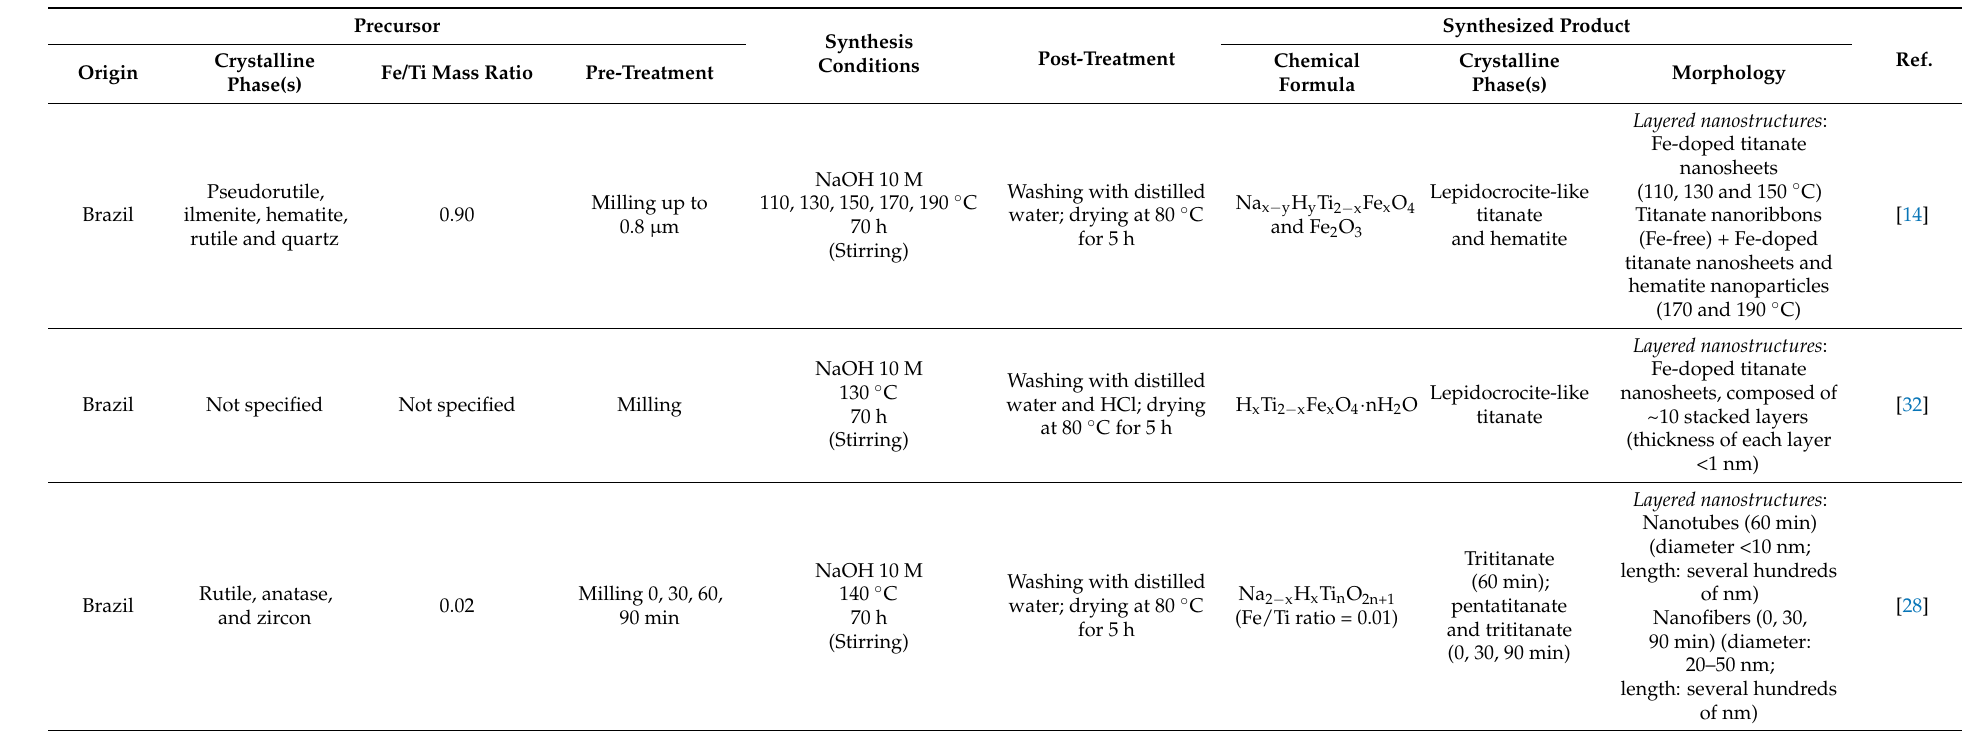
Table 1. Preparation of Fe-Ti-NS: precursors, synthesis conditions and